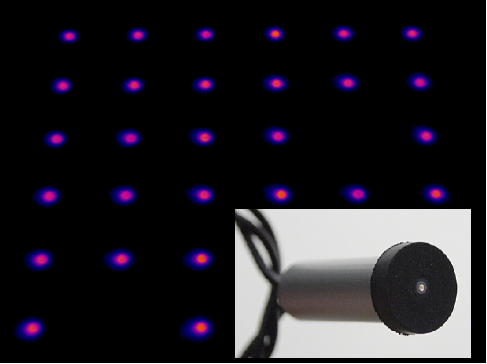
Table 7. Results of Olympus Pen E-PM1 time synchronization